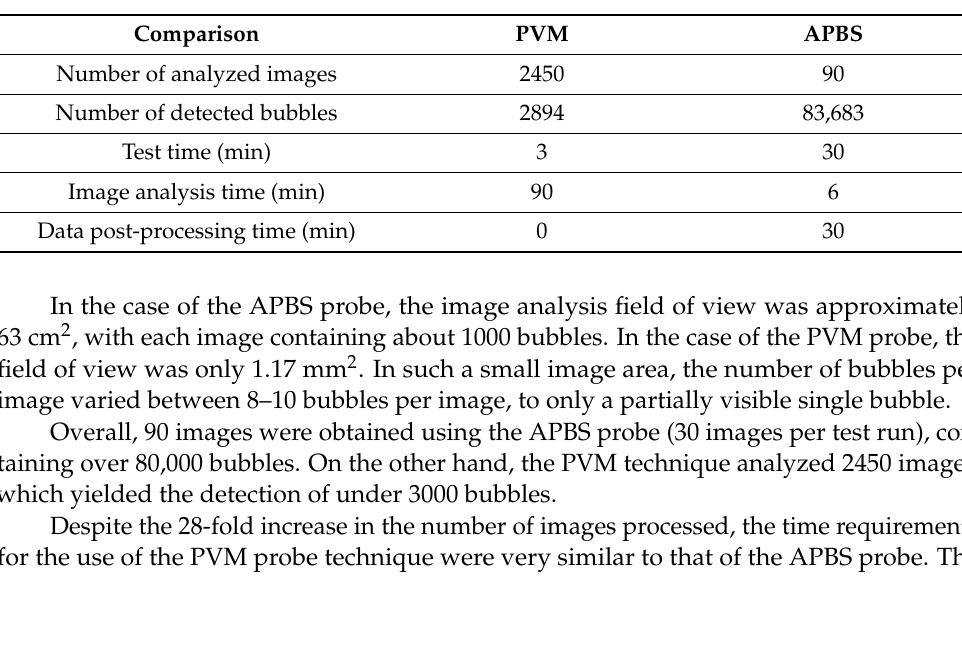
Table 5. Summary of the measurement parameters for PVM and APBS